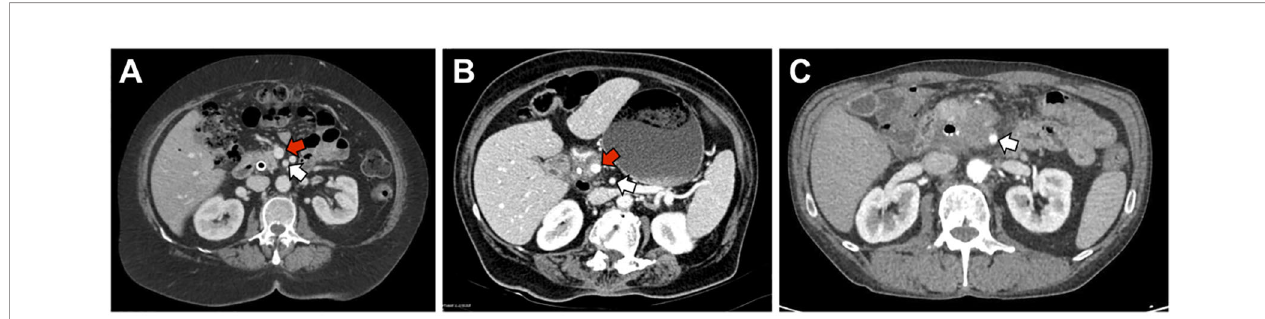
FIGURE 2 | Representative images of resectable, borderline-resectable, and non-resectable PDAC. (A) Representative image of a patient with resectable disease as de fi ned by NCCN guidelines. There is no tumor contact with the superior mesenteric artery (SMA, white arrow) and <180° of tumor contact with the superior mesenteric vein (SMV, red arrow). (B) Patient with borderline resectable disease due to >180° of tumor contact with the SMV but no involvement of the SMA. (C) Patient with locally advanced disease due to >180° of tumor contact with the